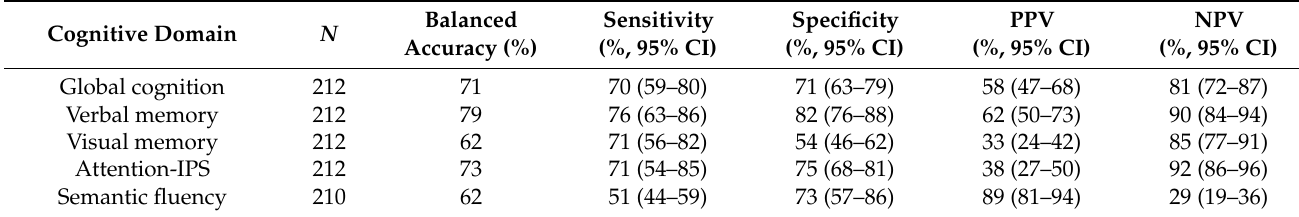
Table 2. Performance evaluation of each Lasso regression model.